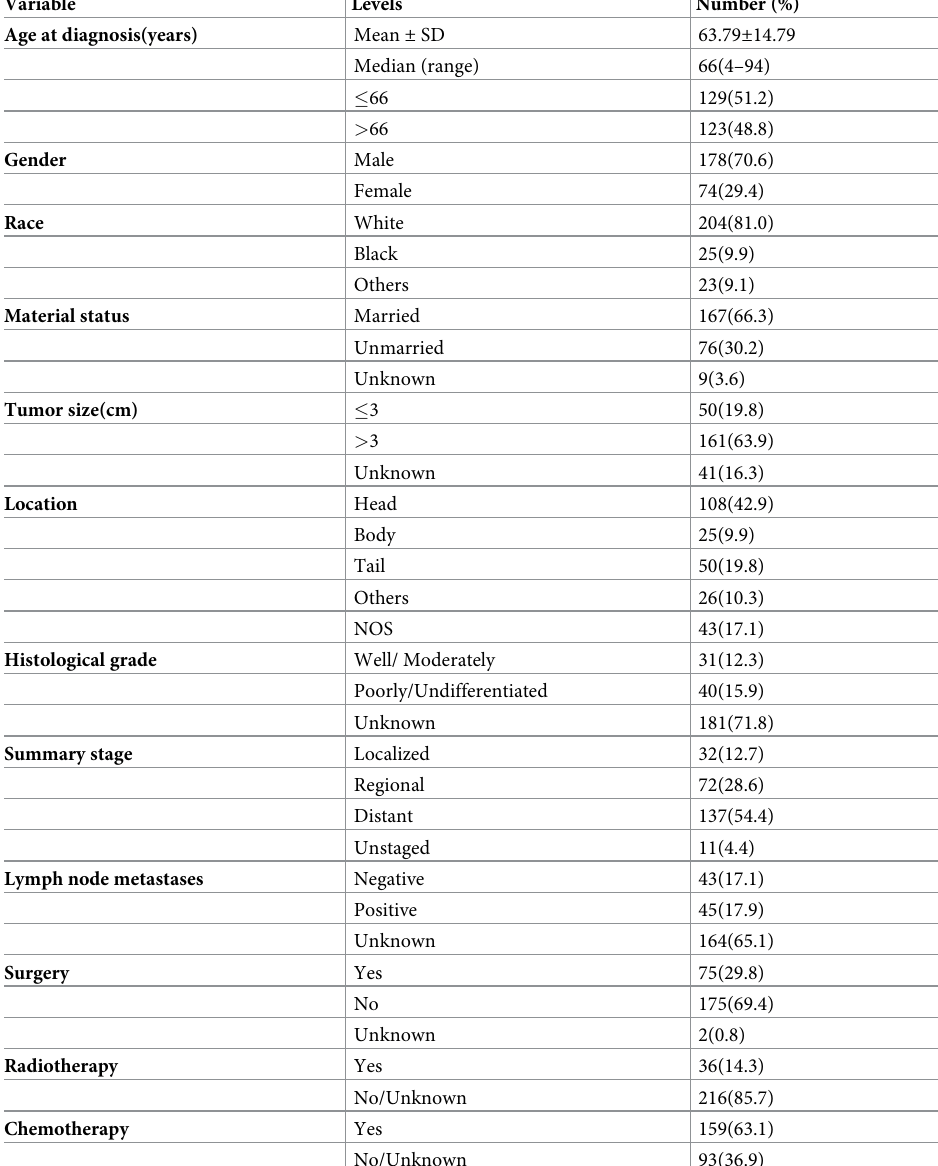
Table 1. The clinicopathologic features of the patients with pancreatic acinar cell